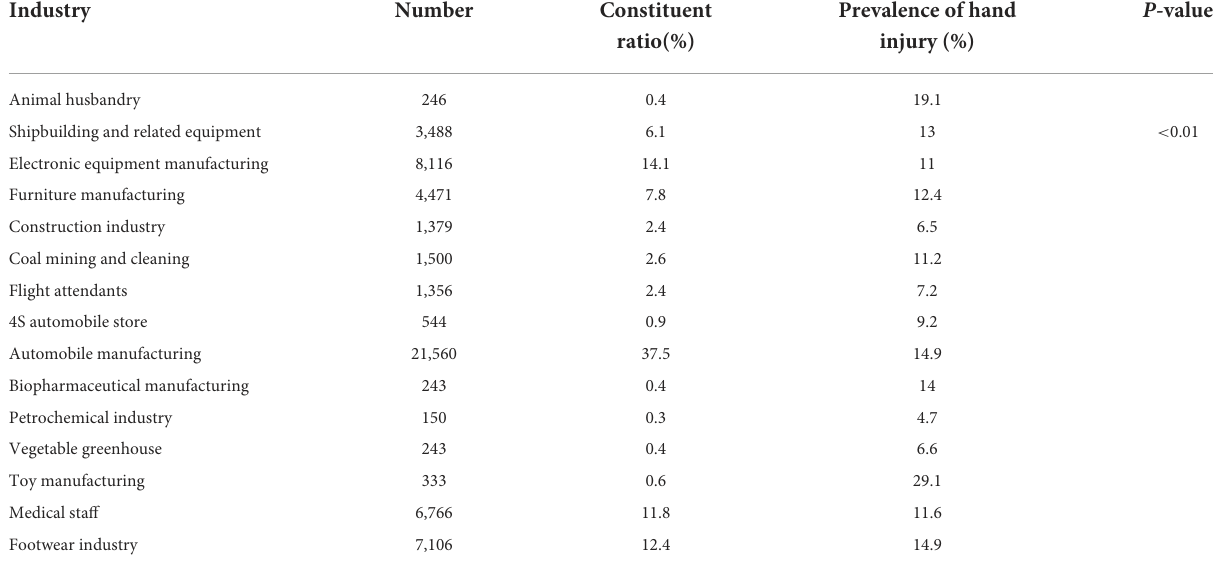
TABLE 2 Wrist injury rate under different industry.